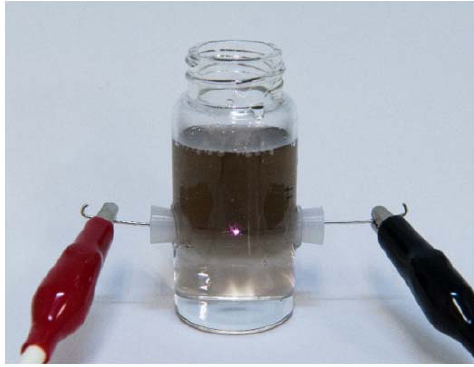
Figure 1. Photograph of vessel used for the in-liquid plasma process.